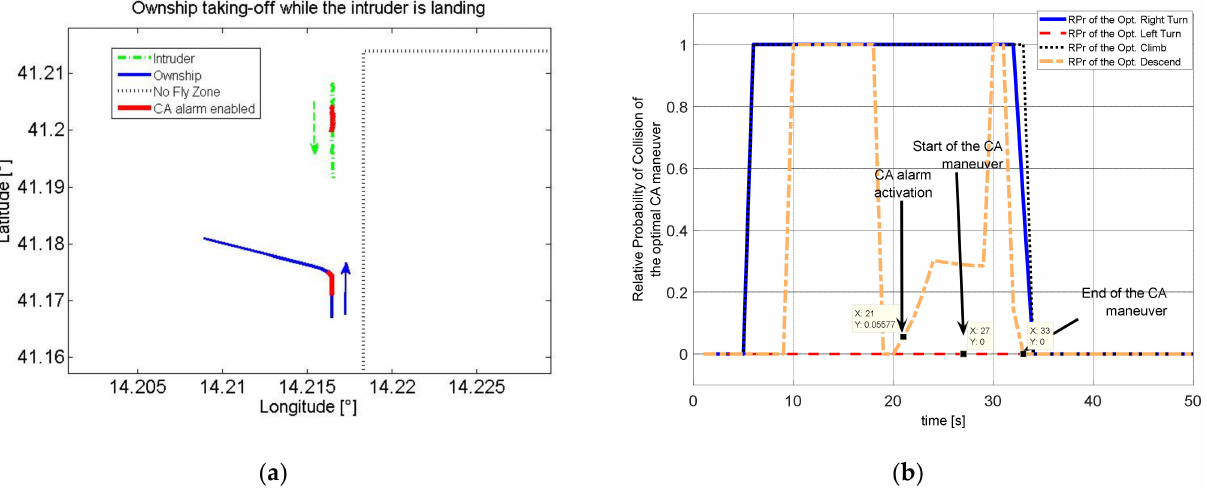
Figure 14. Ownship climbing while the intruder is descending in the presence of a no-fly zone. ( a ) Trajectories; ( b ) RPr Time